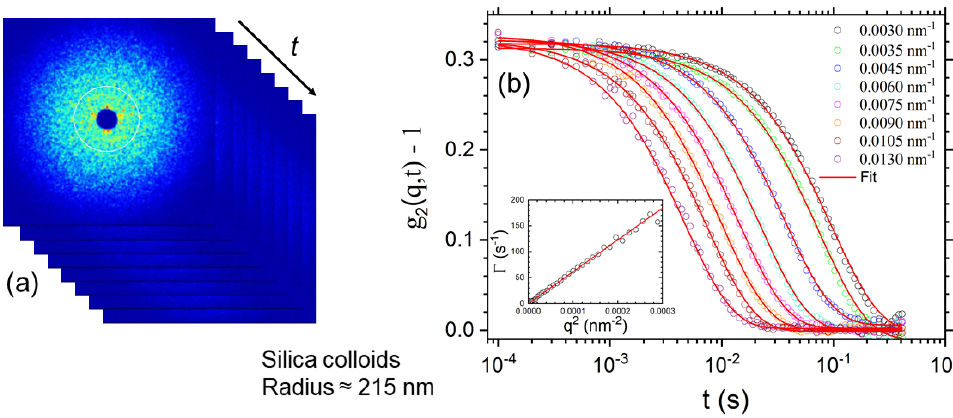
Figure 12. Multispeckle XPCS from a dilute colloidal suspension of silica particles (radius: ~215 nm) in water/3-methylpyridine mixture. ( a ) Representative 2D speckle patterns recorded in the USAXS range and the white circle indicating a given q . ( b ) Typical ensemble averaged intensity-intensity autocorrelation function ( g 2 ( q , t ) ) and fits to an exponential decay with rate, Γ . The inset shows that Γ = D 2 , with D ∼ 0.6 µ m 2 s − 1 , as expected for dilute Brownian 0 q 0